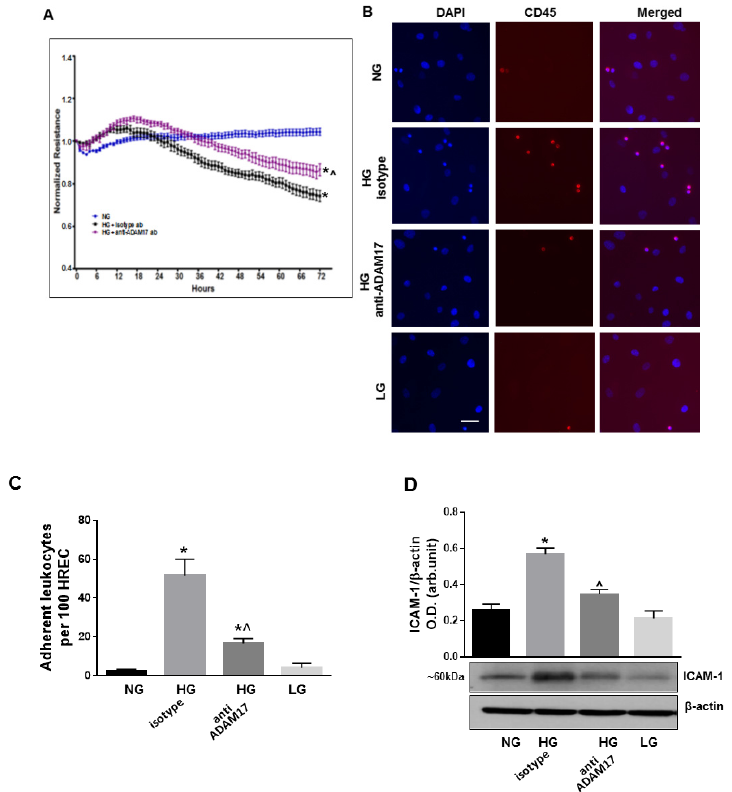
Figure 7. Effects of ADAM17 blocking antibody on high glucose-induced endothelial cell permeability, leukocyte adhesion and ICAM-1 expression. ( A ) TER in HREC monolayers treated with HG in the presence of ADAM17 blocking antibody or control isotype antibody using ECIS. Data presented as mean ± SE. * p < 0.05 NG vs. HG. ˆ p < 0.05 HG + isotype vs. HG + anti-ADAM17 antibody. n = 3. ( B ) Representative images of leukocytes adherent to HREC exposed to HG in the presence of 0.5 µ M ADAM17 blocking antibody D1(A12) or control isotype antibody. Scale bar, 50 µ m. ( C ) Quantitative analysis of leukocyte adhesion. Data are expressed as a number of adherent cells per 100 HREC. * p < 0.05 NG vs. HG. ˆ p < 0.05 HG + isotype vs. HG + anti-ADAM17 antibody. n = 3. ( D ) Representative blots and densitometric analysis of ICAM-1 expression in HREC treated with HG in the presence of ADAM17 blocking antibody or control isotype antibody. Data presented as mean ± SE. * p < 0.05 NG vs. HG + isotype antibody. ˆ p < 0.05 HG + isotype vs. HG + anti-ADAM17 antibody. n =